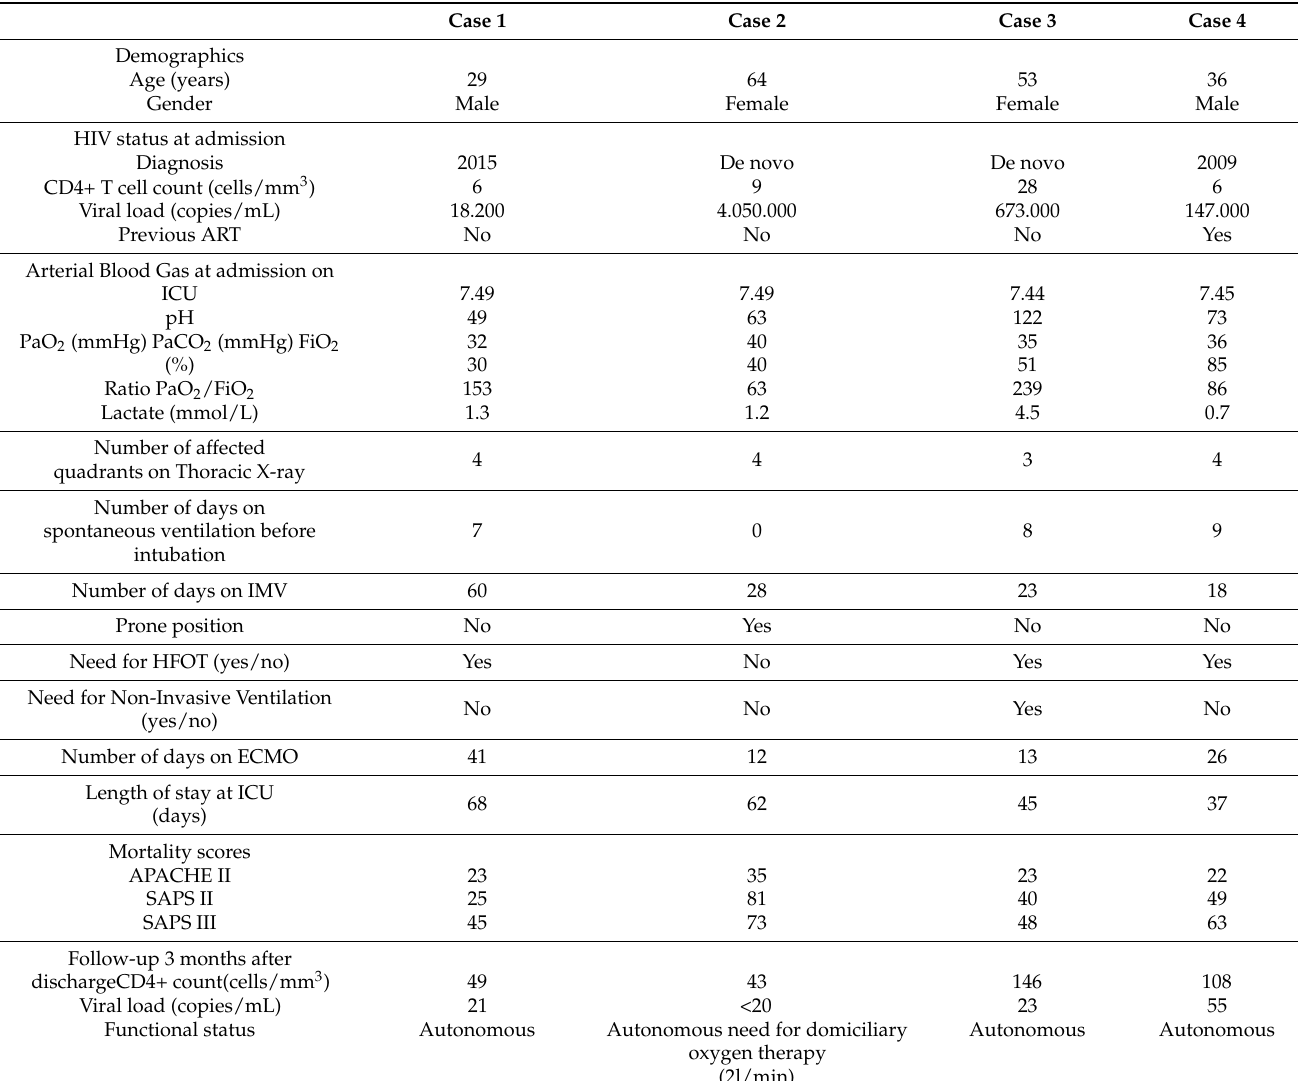
Table 1. Resume of the patients’ characteristics and